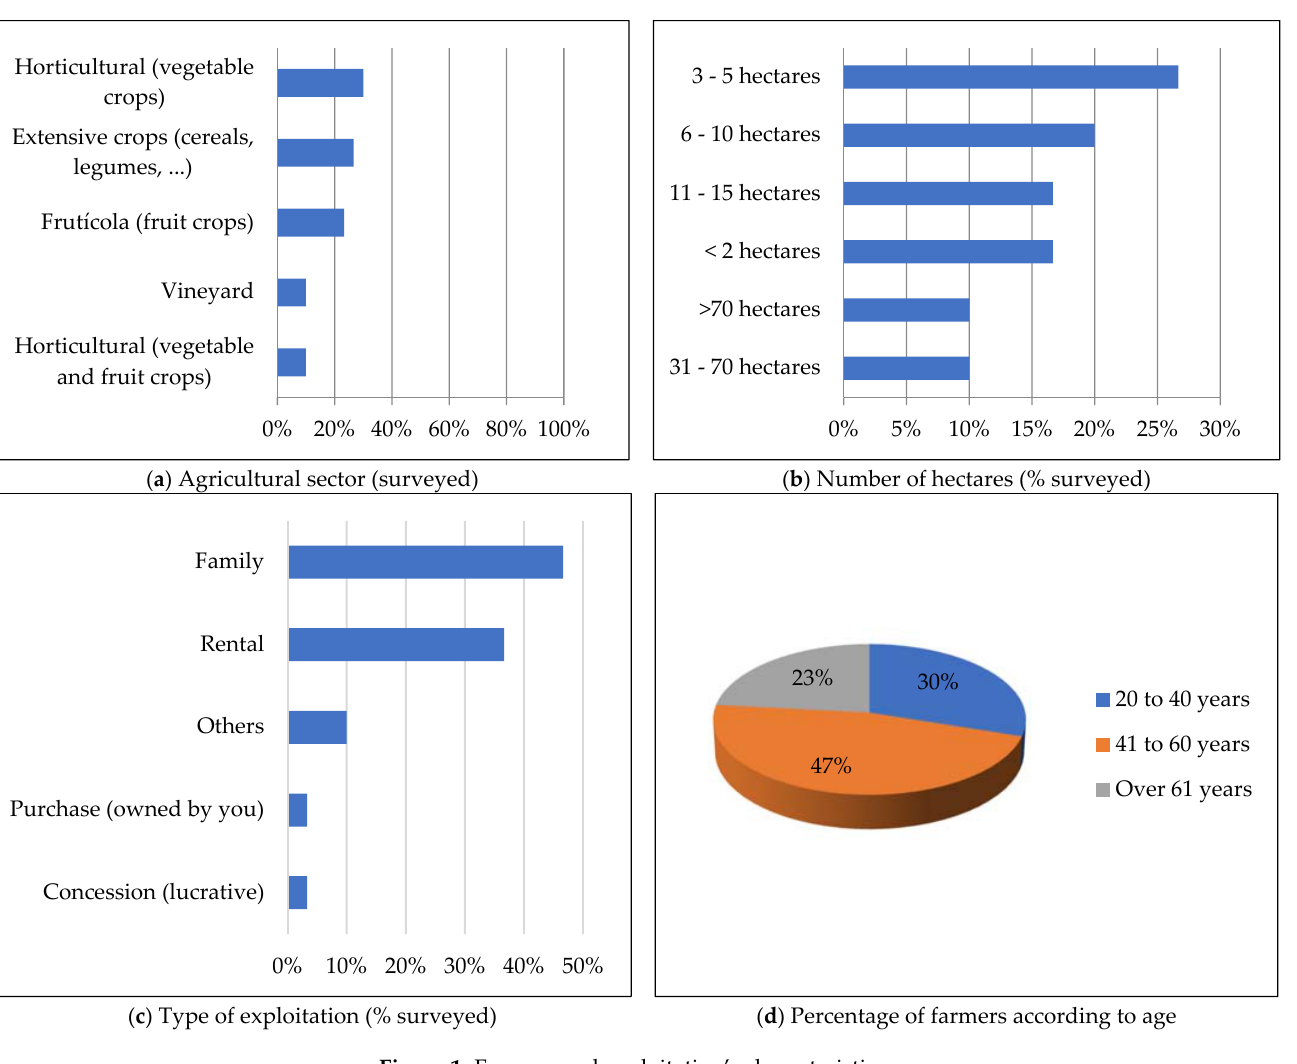
Figure 1. Farmers and exploitation’s characteristics.